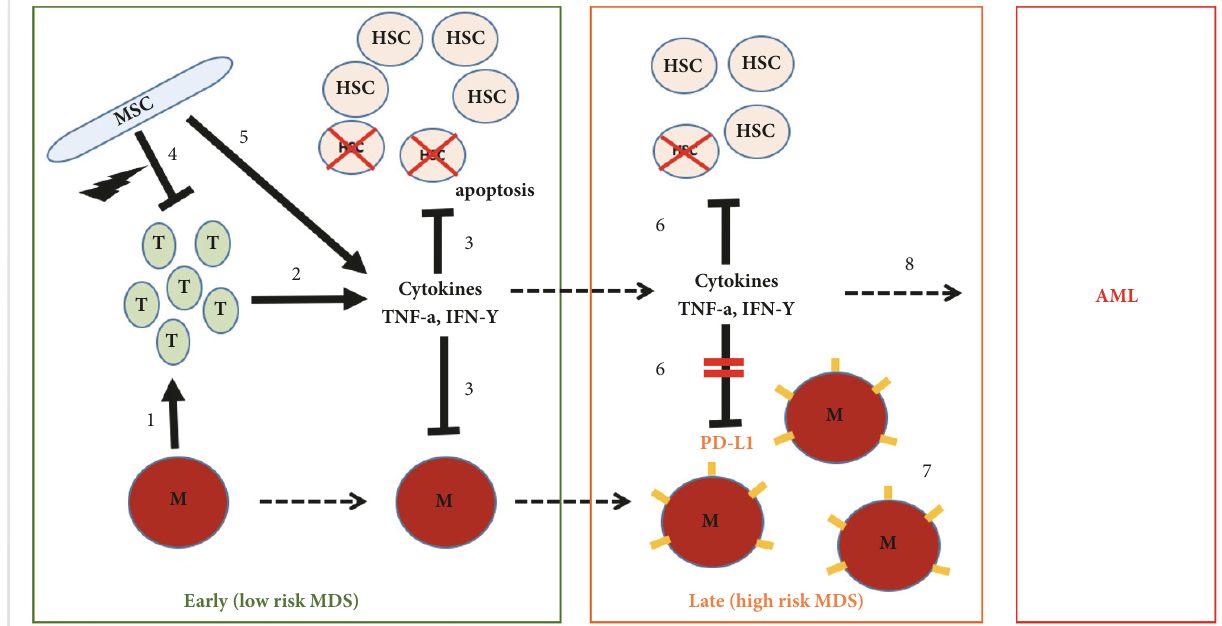
Figure 1: Immune mechanisms in MDS. Early (low risk) MDS . (1) Malignant MDS cells (M) induce clonal expansion of CD8+ T-cells (T). (2) CD-8+ T-cells produce cytokines like TNF-a and INF-Y. (3) This results in apoptosis in hematopoietic stem cells (HSC) resulting in cytopenias but also keep MDS cells (M) from proliferating. (4) MSC in normal hematopoiesis suppress T-cell activation, a process that is aberrant in MDS. (5) MSC also produce proinflammatory cytokines. Late (high risk) MDS . (6) While continued inflammation leads to more apoptosis of hematopoietic stem cells (HSC) and cytopenias worsen, TNF-a and INF-Y start inducing PDL-1 expression on MDS clonal cells. (7) PD-L1 allows the MDS cells to escape immune surveillance by T-cell suppression. AML. (8) MDS transitions into acute myeloid leukemia